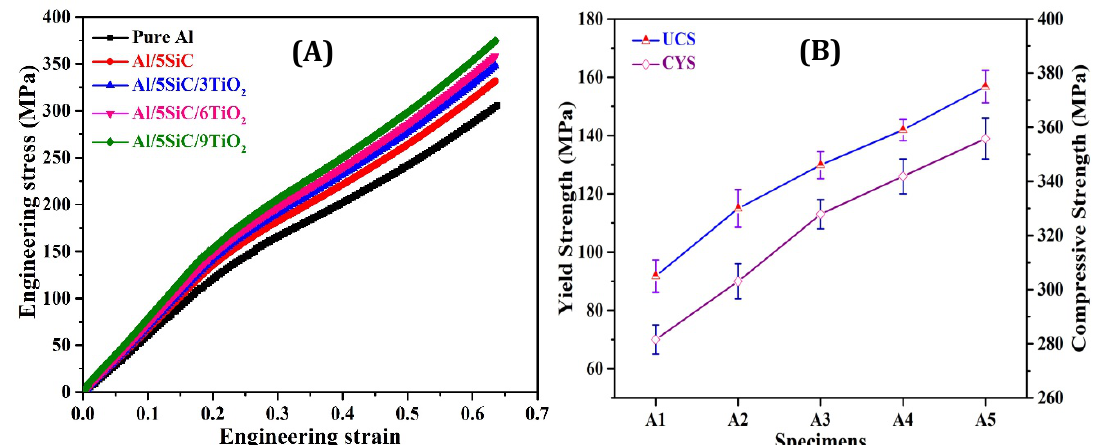
Figure 10. ( A ) Compressive stress/strain curves, ( B ) compressive strength of the Al/SiC/TiO 2 hybrid nanocomposites.